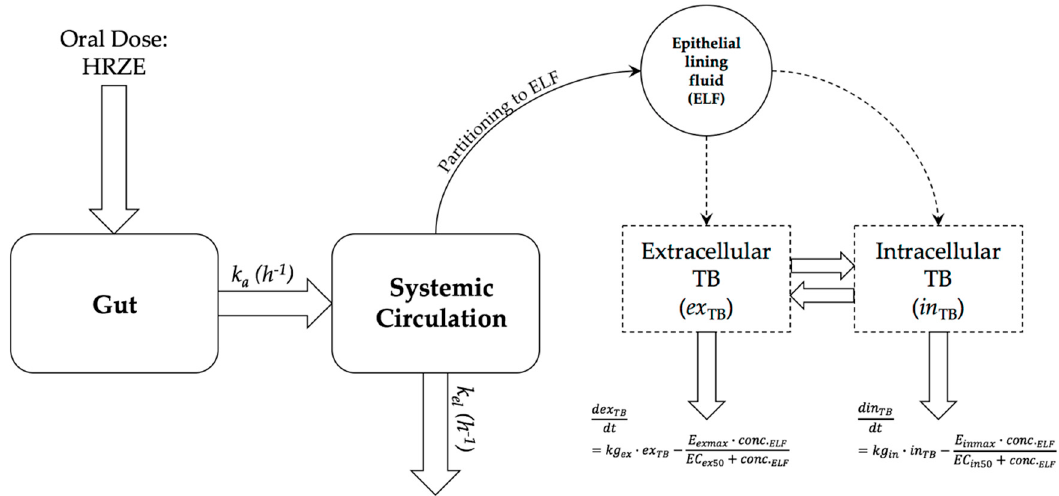
Figure 1. Mathematical model used to predict overall Mtb count in silico. k a is rate of absorption in hours, k el is the rate of elimination from the systemic circulation per hour. ELF concentration is assumed to be a fraction of the systemic circulation concentration of each drug at any given time. Respectively, ex TB and in TB are the number of extracellular and intracellular tuberculosis bacteria, kg ex and kg in the rates of extracellular and intracellular bacterial growth, E exmax and E inmax are the maximal kill rates against extracellular and intracellular bacteria, and EC 50ex and EC 50in are the half-maximal-e ff ect drug concentrations in the extracellular or intracellular environment for each drug. conc. ELF is the drug concentration in the ELF. plasma drug concentration for each drug detailed in Equations (1)–(4), where Gutx is a drug mass